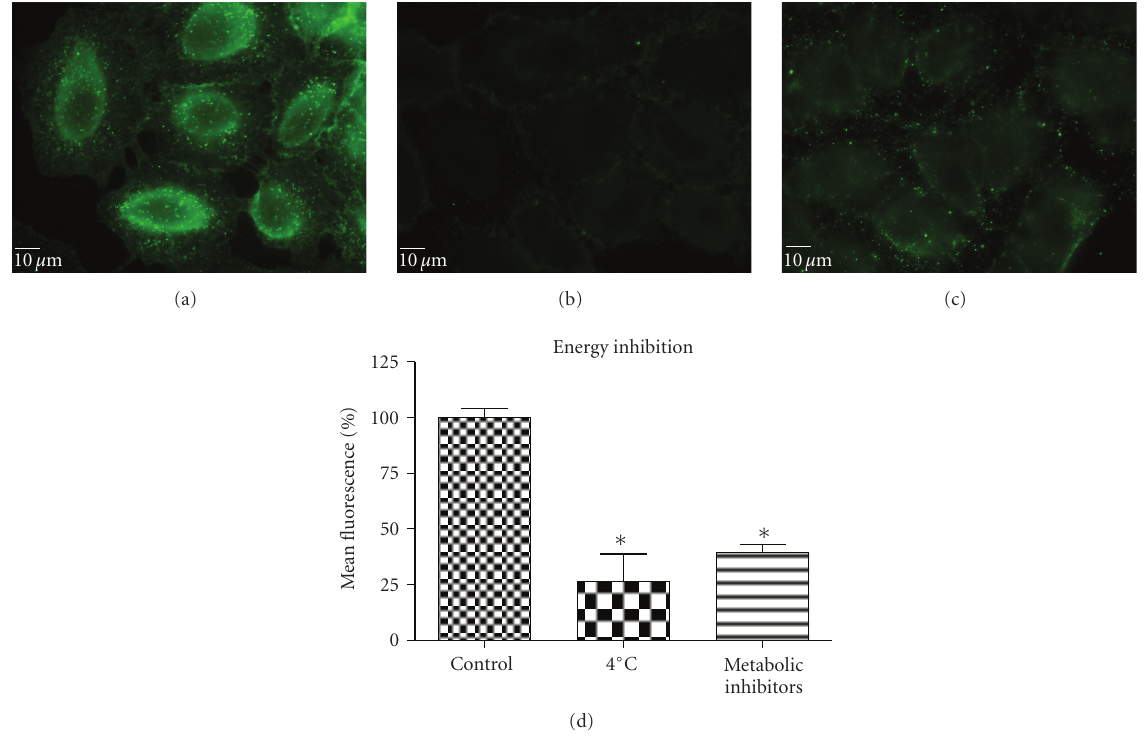
Figure 6: Energy inhibition reduced internalization of QD/SR9 (150nM; 1 :20; 1 hour). (a) Control cells. (b) Cells pretreated at 4 ◦ C for 30min then incubated with QD/SR9 for an additional 1 hour. (c) Cells pretreated with a metabolic inhibitor mixture for 1 hour then incubated with QD/SR9 for an additional 1 hour. Images are from a single plane of Z series. (d) Fluorescence intensity. Values are mean ± SD from three independent experiments ( ∗ P (cid:5) s < . 01 versus